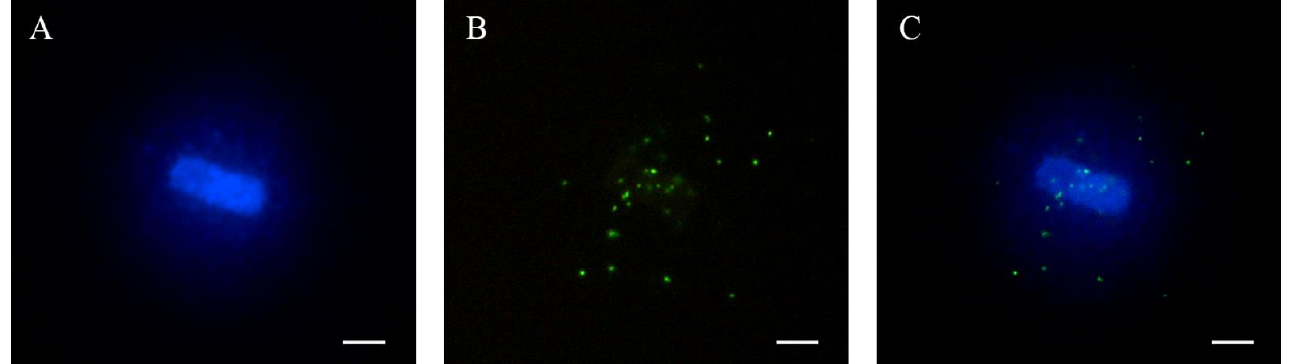
Figure 1. Representative images of a pig sperm halo ( A ) stained with DAPI, ( B ) telomeres labeled through the qFISH method and ( C ) merged images. Scale bar represents 5 µ m. through the qFISH method and ( C ) merged images. Scale bar represents 5 µ